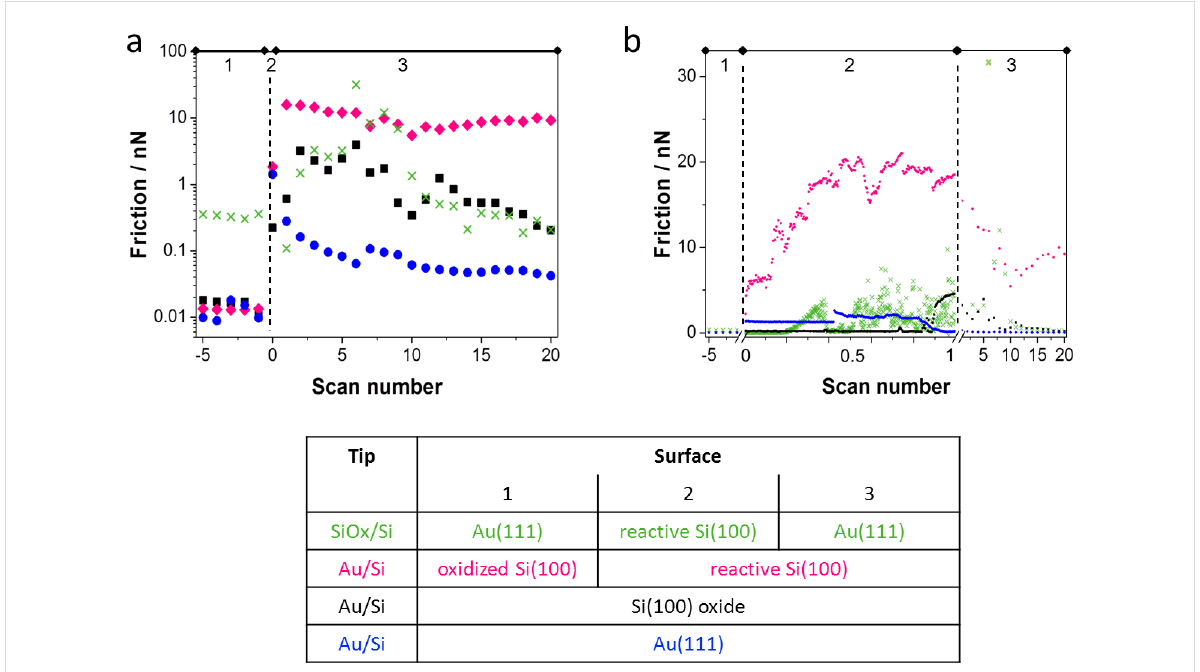
Figure 3: Development of friction for different tip–surface pairs upon activation of the interface. 1 – Control experiment with intact surface and tip; 2 – onset of activation; 3 – friction values for scanning sequences after activation. a) Emphasis on average friction values per scan before and after activation. b) Emphasis on the onset of the interfacial reaction showing the average friction values per scan line for the frame in which the activation